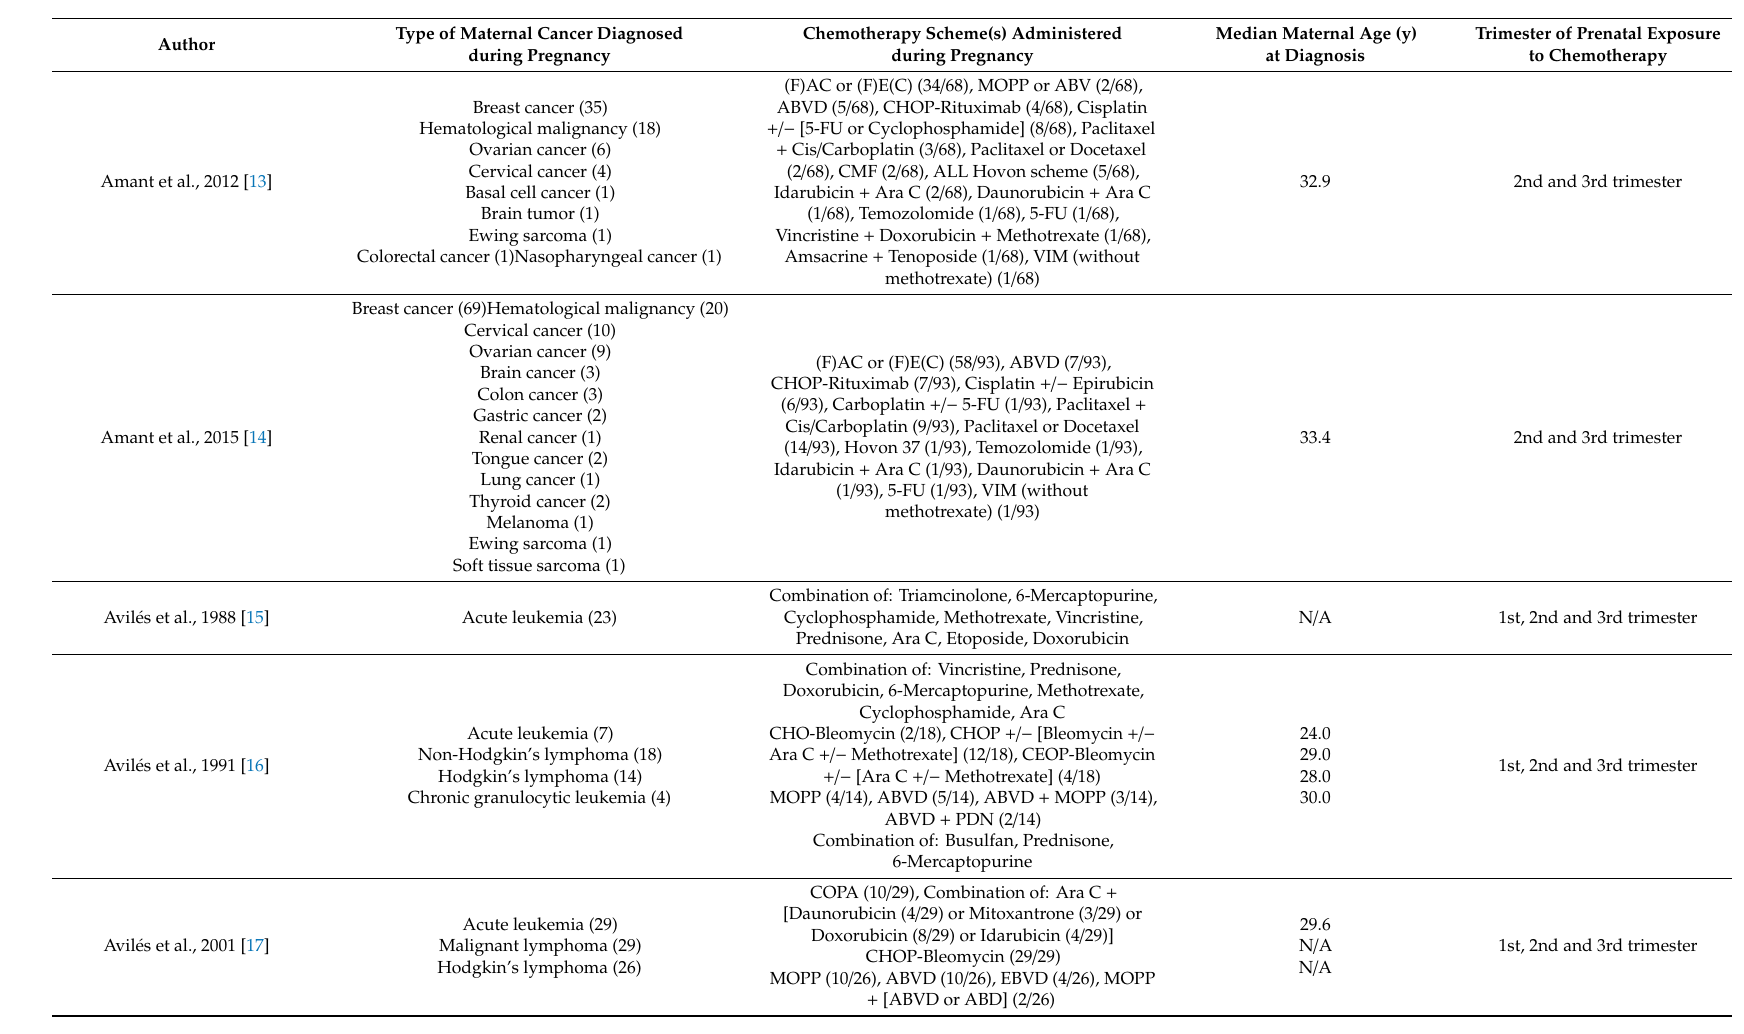
Table 1. Summary of the studies describing the type of maternal cancer and the chemotherapy scheme(s) administered during